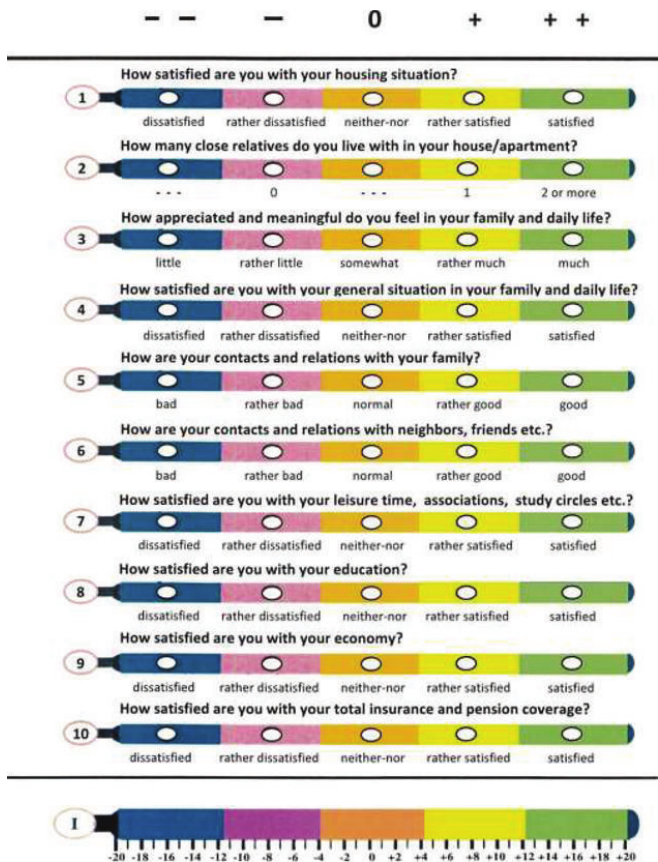
Figure 3: English translation of ordinal VAS scales in the social health section of the elderly health version.